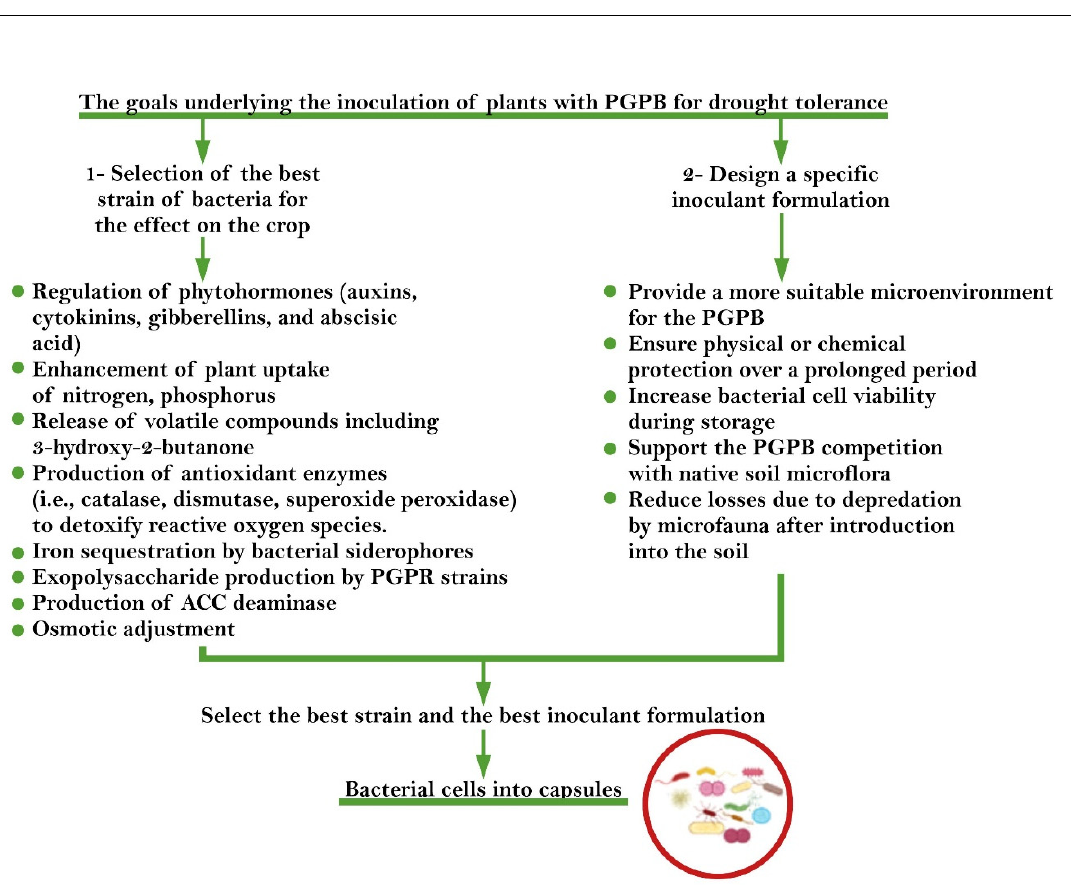
Figure 1. Strategies for selecting the best method and the optimal bacterial strain for encapsulation.